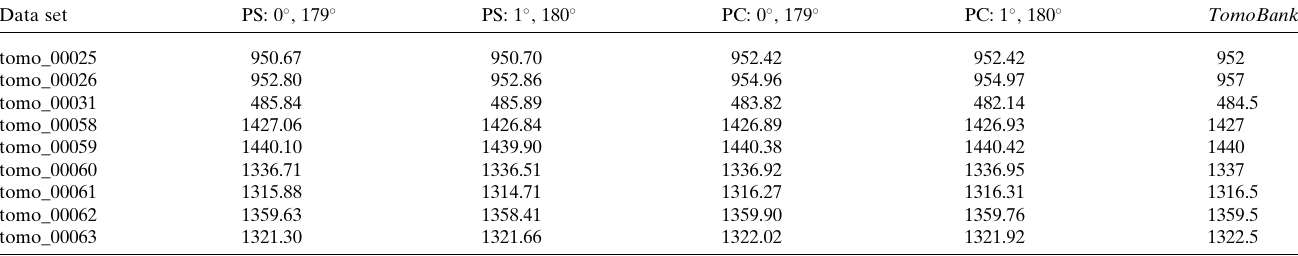
Table 2 COR results on TomoBank (De Carlo et al. , 2018) data sets compared with their reported COR position in pixels, showing reproducibility of both the phase correlation approach (PC) and the phase symmetry (PS) approach described here (which offers faster calculation speed, and improved robustness against noise). Since most data sets in TomoBank have a total angular range of only 180 (cid:2) , we compared the COR calculated using two independent (near) reflection pairs: one at 0 (cid:2) and 179 (cid:2) , and another at 1 (cid:2) and 180 (cid:2) . As can be seen, the COR position is consistent to a fraction of a pixel in all cases when using the PS approach, in most other cases the PC approach gives similar values to both the PC approach and the COR position recorded in the TomoBank deposition (final column), with slight discrepancies in the first three data sets. Data